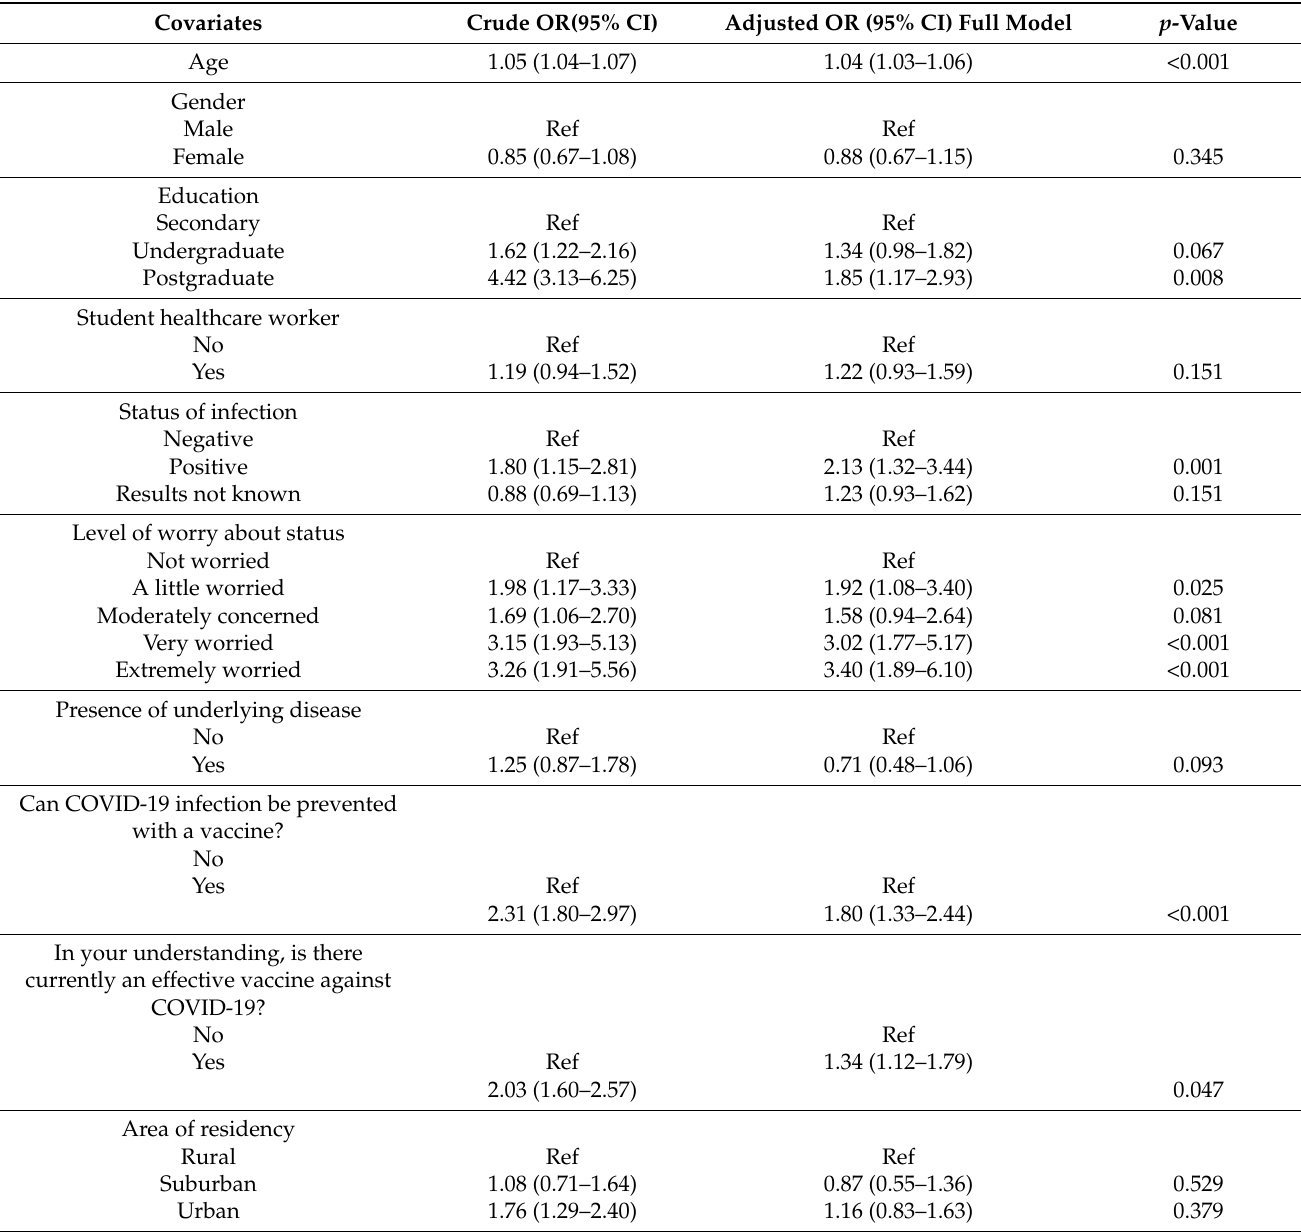
Table 2. Factors associated with COVID-19 vaccine acceptance in